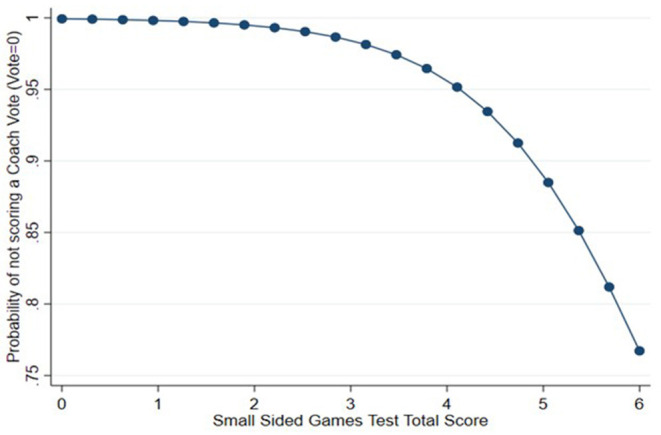
The probability of not scoring a coach vote in relation to small sided games test score.